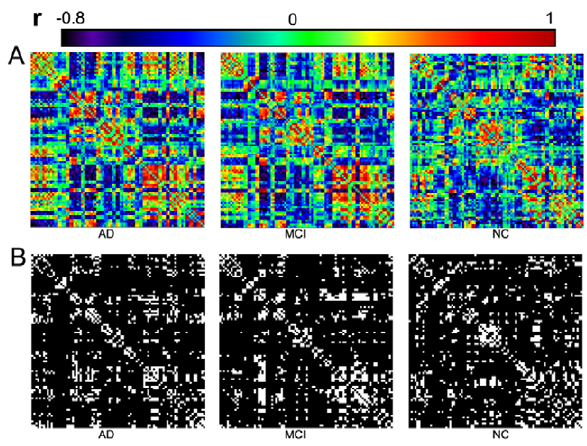
Figure 1. The interregional correlations matrix in the AD, MCI and NC groups. The color bar indicates the value of the correlation coefficient r (ranging from 2 0.8 to 1). A . The correlations matrices obtained by calculating the correlations between pairs of AAL areas within each group (left - the AD group, middle - the MCI group and right - the NC group). B . The binarized matrices obtained by thresholding the above correlations matrices of A with a sparsity threshold (15%). The sparsity threshold sets the same number of nodes and edges in each of the three cortical networks.